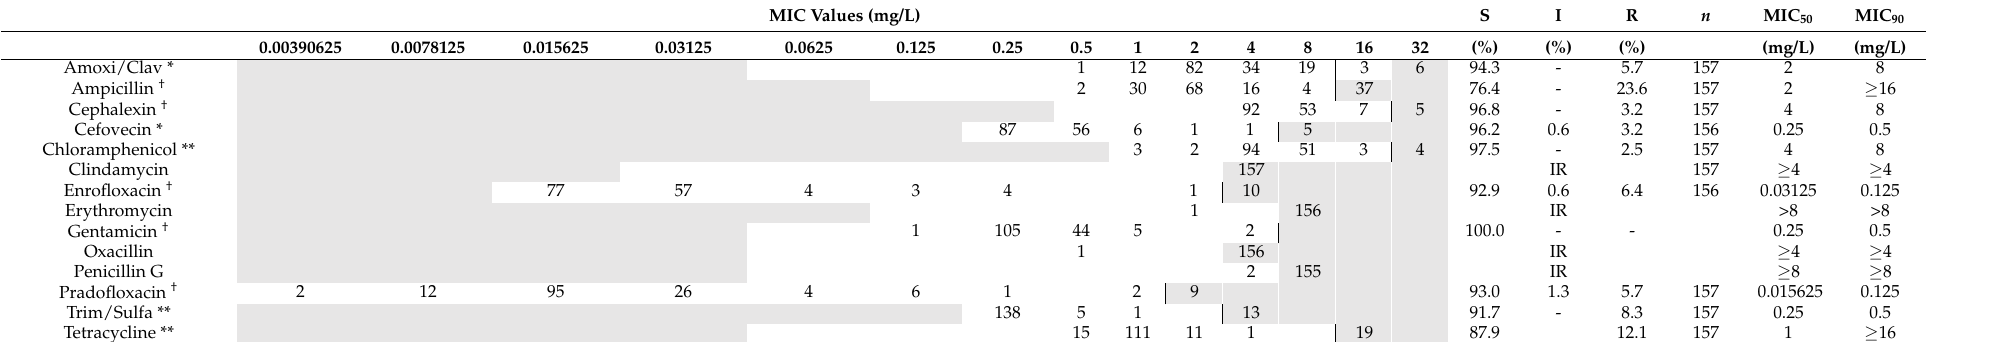
* Indicates that CLSI breakpoints derived from animal breakpoints were used. ** Indicates that CLSI breakpoints derived from human breakpoints were used. † Indicates that CLSI breakpoints derived from the other animal species (referring to dog and cat) were used. S = susceptible, R = resistant, I = intermediate, IR = intrinsic resistance. The dilution ranges tested are those contained in the white area, and values shown above this range are greater than or equal to the concentration shown. Values at the lower end of these ranges are less than or equal to the lowest concentration tested. Where available, breakpoints are indicated by the vertical line. Grey shaded areas indicate concentration of antimicrobial not